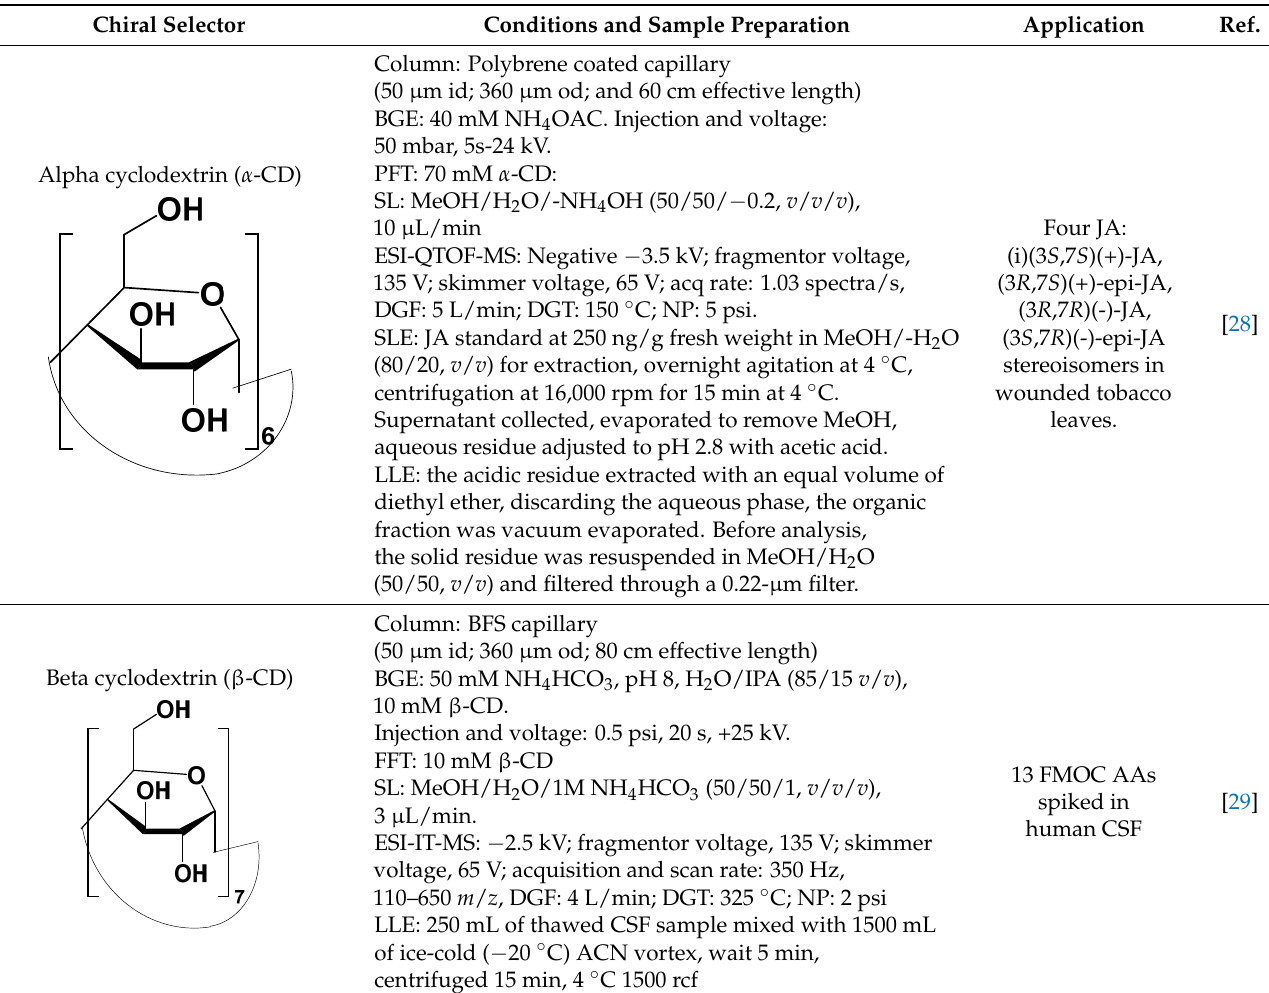
Table 1. Different types of chiral selectors and their applications in EKC-MS and LEKC-MS. Chiral Selector Conditions and Sample Preparation